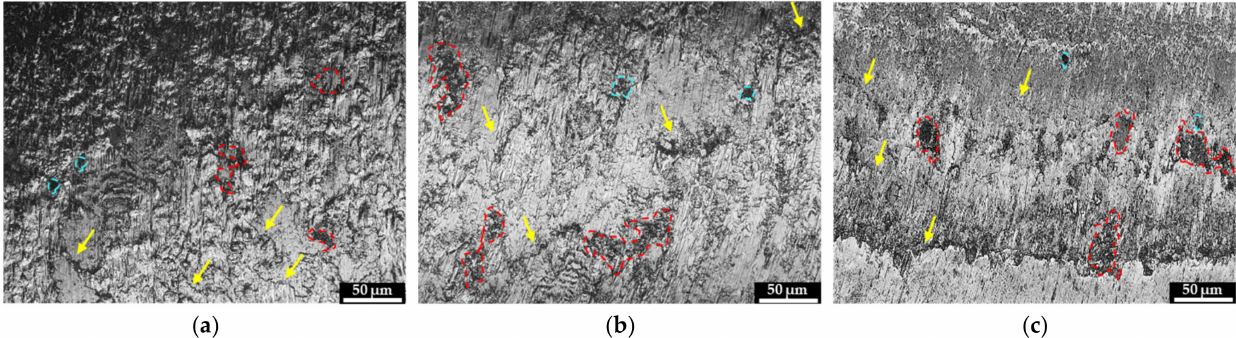
Figure 8. Optical micrographs of ( a ) non-clad light rail, ( b ) SS412, and ( c ) Stellite 6 cladding deposi- tions on light rail specimen. Red boundaries represent regions of spalling, blue boundaries represent pitting, and yellow arrows indicate surface